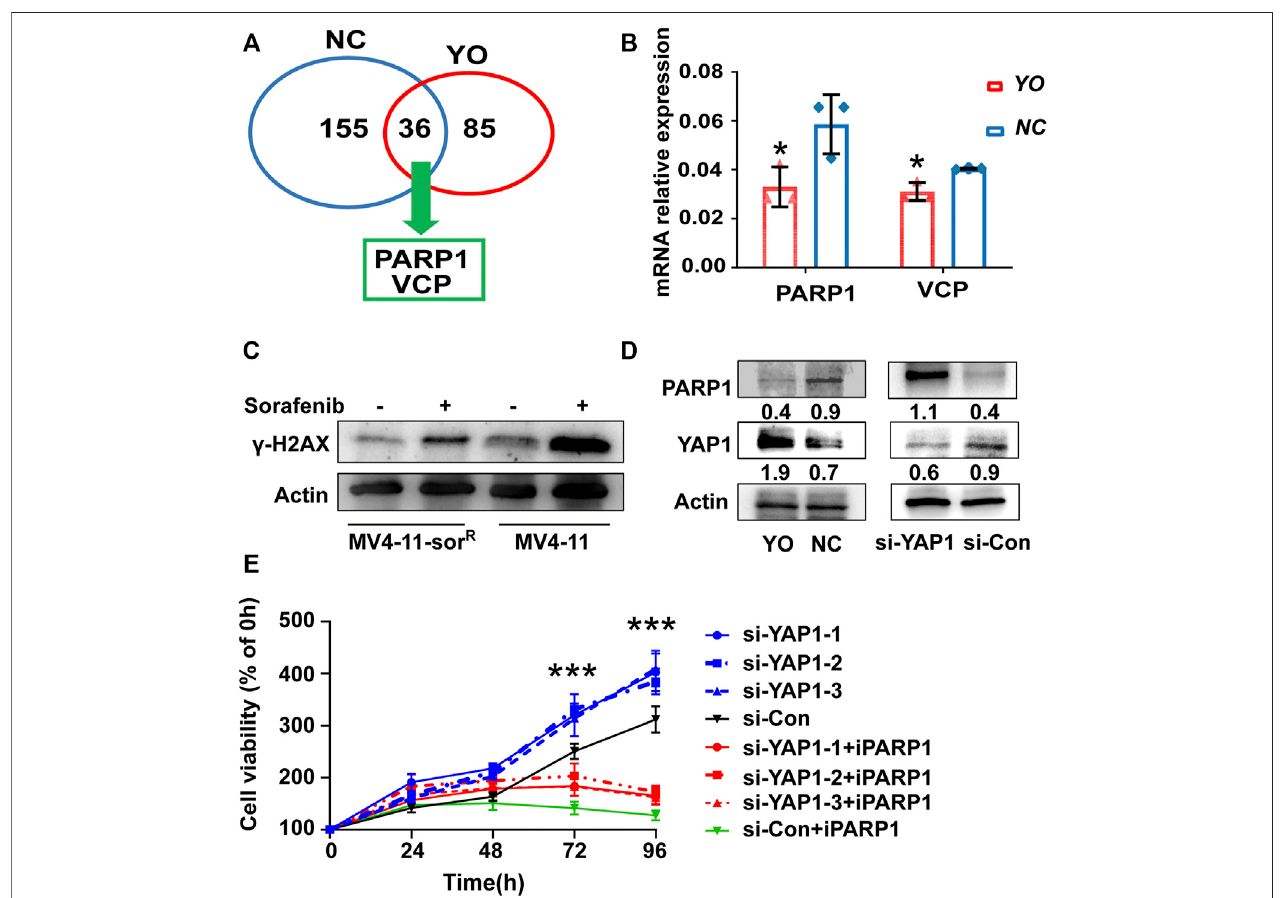
FIGURE 3 | YAP1 suppression promoted FLT3-ITD + AML cell resistance through DNA damage response dependent of PARP1. (A) Mass spectrometry analyzed selectedproteins(ScoreSequestHT ≥ 1.5)ofYO(red)andNC(blue)cells. (B) RT-qPCRdetectedthemRNAexpressionlevelofPARP1andVCPinYOandNCcells. (C) γ - H2AXproteinexpressionofMV4-11-sor R andMV4-11cellswasexaminedafter6 hoftreatmentwithorwithoutsorafenib(50 nM). (D) PARP1andYAP1proteinexpression was analyzed by Western blot in YO and NC cells as well as in YAP1 knockdown (si-YAP1) and non-silencing scrambled control (si-Con) cells, respectively. (E) Proliferation ofsi-YAP1 and si-Con cells with or without PARP1 inhibitor Olaparib (iPARP1) was assessed by CCK8 assays, and viable cellrates at 12, 24, 48, 72, and 96 h were calculated normalized to the absorbance at 0 h. Data are shown as mean ± SD of three independent experiments; * p < 0.05; ** p < 0.01; *** p < 0.001.